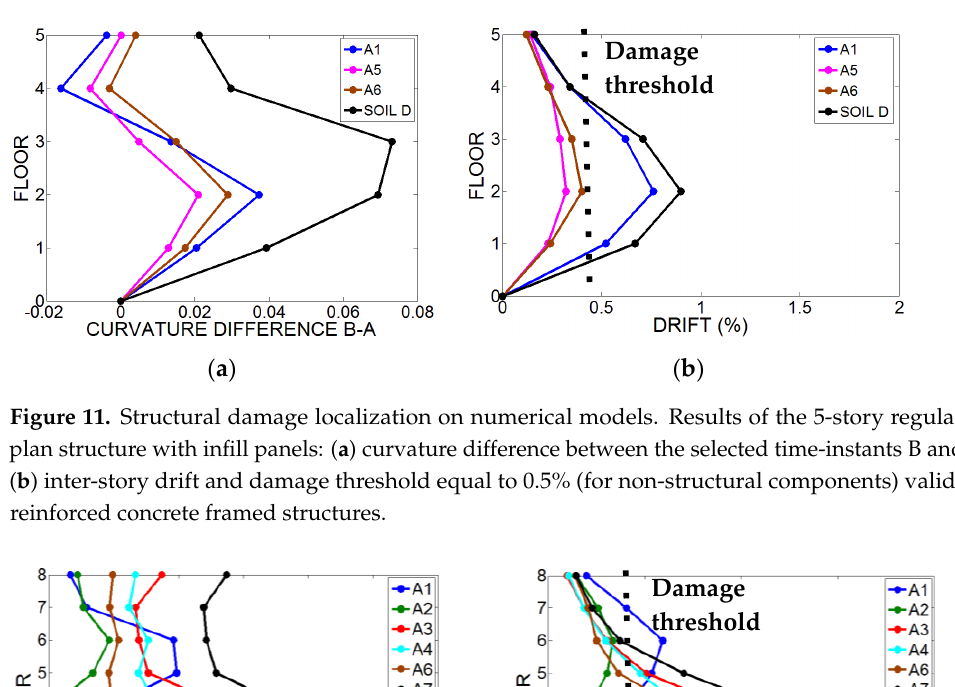
Figure 10. Structural damage localization on numerical models. Results of the regular in plan 5-story structure: ( a ) curvature difference between the selected time-instants B and A; ( b ) inter-story drift and damage threshold equal to 0.5% (for non-structural components) valid for reinforced concrete framed structures.